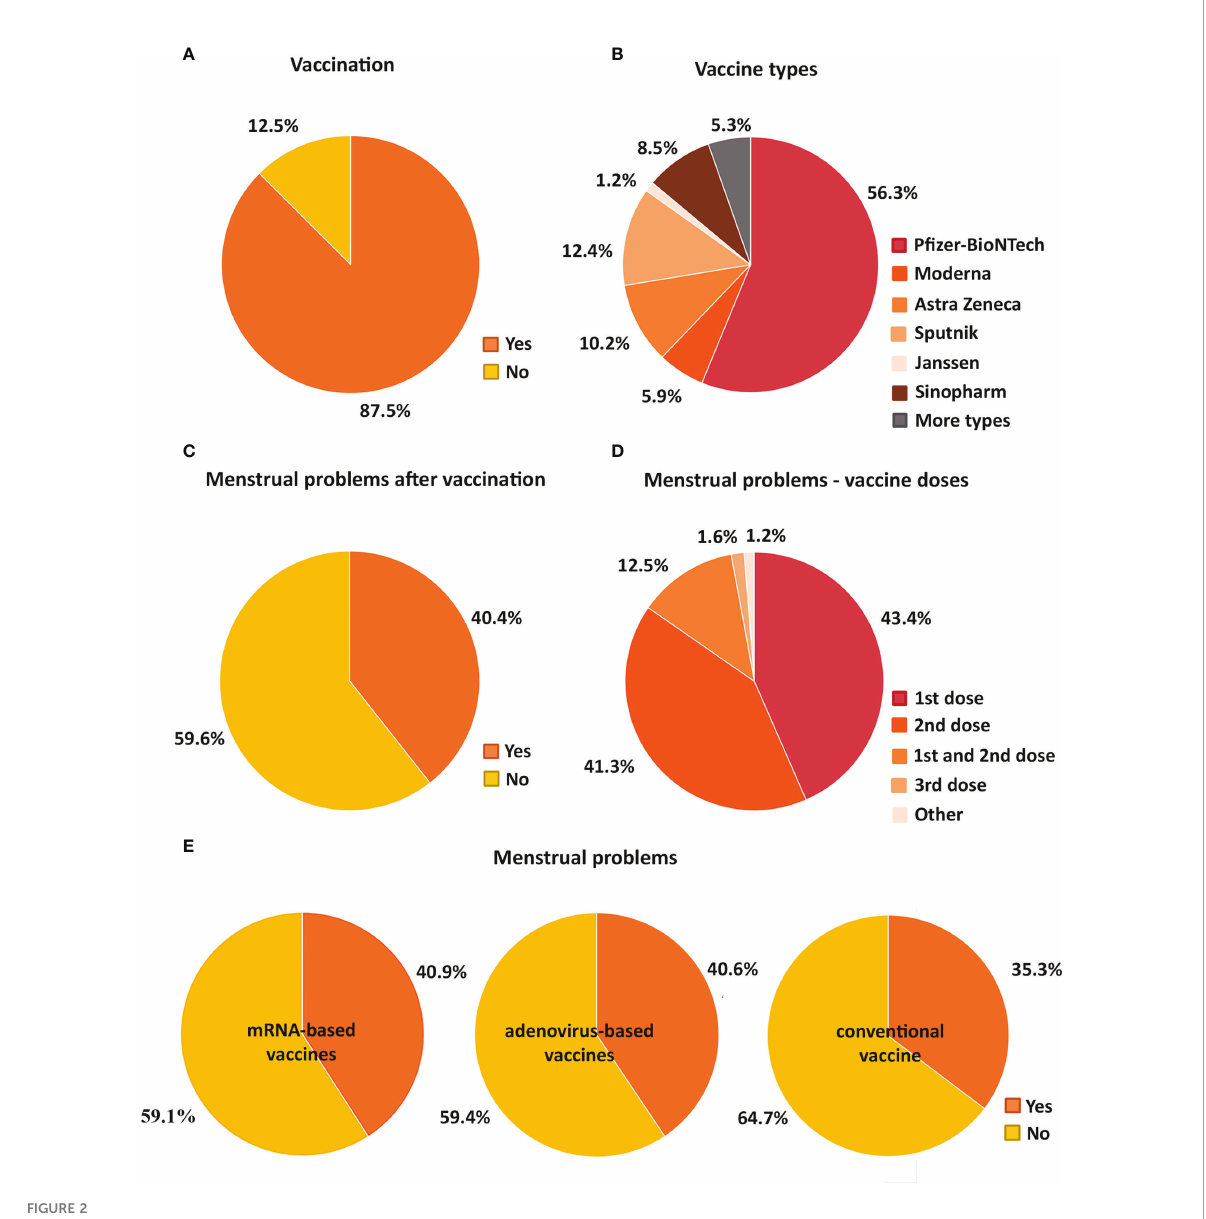
FIGURE 2 Pie charts demonstrate the percentage of vaccinated and unvaccinated individuals (A) and the proportion of the types of vaccines received in the vaccinated group (B) . The percentage of participants with and without menstrual cycle problems after vaccination is also shown (C) . It is also indicated how many doses of vaccine were given to those with menstrual cycle problems (D) . In addition, pie charts show how the proportion of individuals with menstrual problems and without menstrual problems varied for mRNA-based (P fi zer-BioNTech, Moderna), adenovirus-based (AstraZeneca, Sputnik, Janssen) and conventional vaccines (Sinopharm) (E)